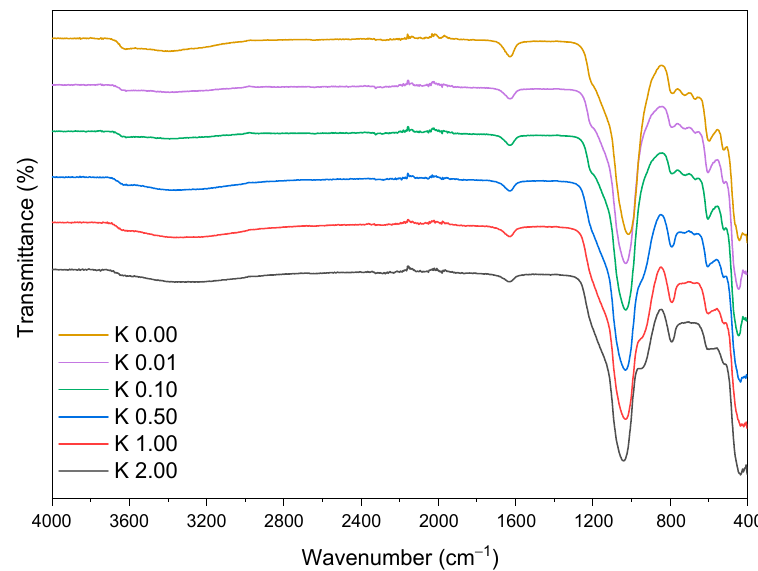
Figure 1. FTIR spectra of the neat and modified clinoptilolite.